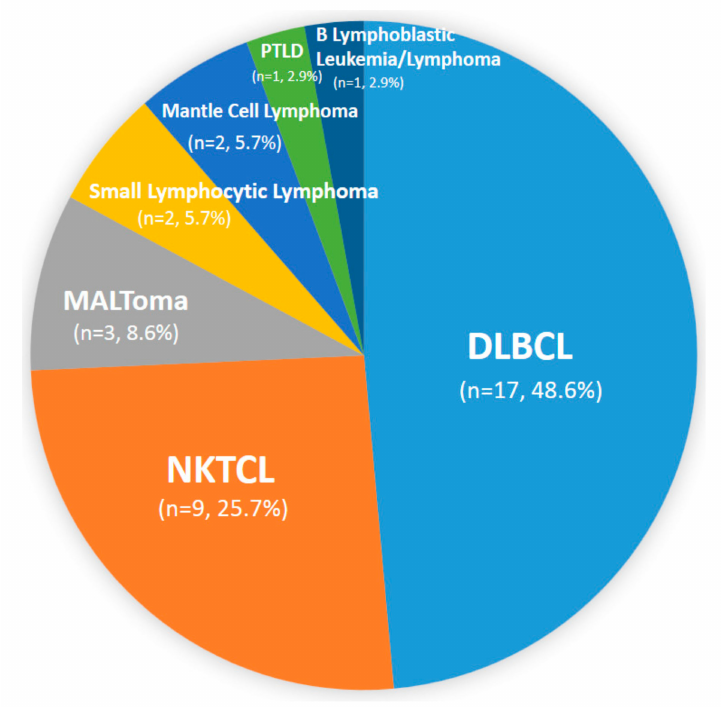
Figure 1. Histological subtypes of nasopharyngeal (NP) lymphoma. Abbreviations: DLBCL: di ff use large B cell lymphoma; NKTCL: NK / T cell lymphoma; MALToma: extranodal marginal zone lymphoma of mucosa-associated lymphoid tissue; PTLD: post-transplant lymphoproliferative disorder.